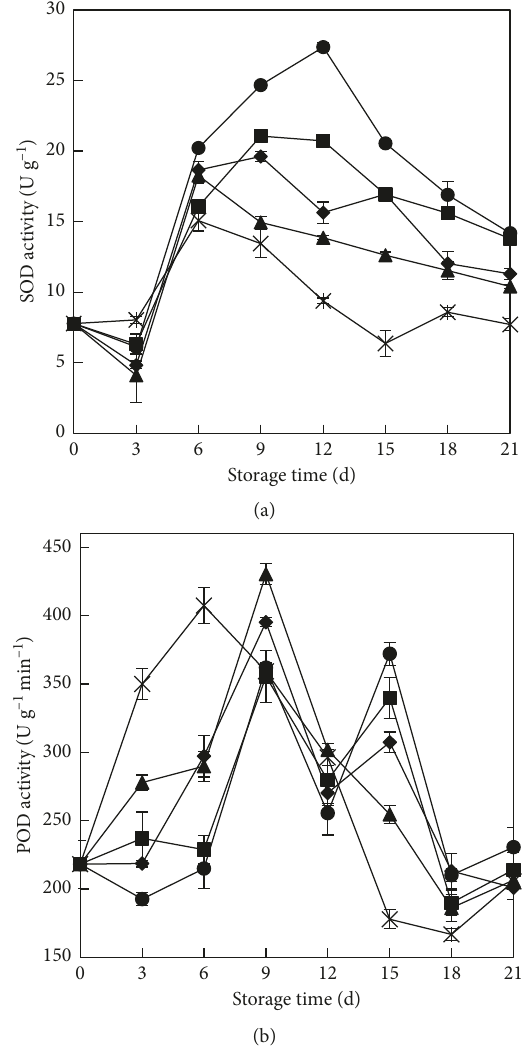
Figure 4: Effects of 1-MCP treatment on SOD (a) and POD (b) activities of yardlong bean during storage at 8 ° C. Each data point is the average of nine fruits. Error bars represent the standard error of the means. Control ( ✲ ), 0.75 μ L · L − 1 ( ■ ), 1.0 μ L · L − 1 ( • ), 1.25 μ L · L − 1 ( ◆ ), and 1.5 μ L · L − 1 ( ▲